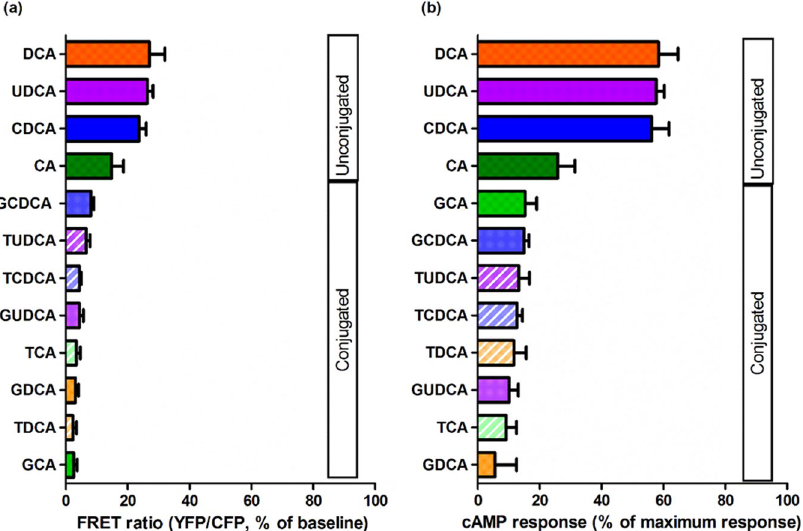
Figure 2. Bile acids and their conjugates ranked by their potency in inducing cAMP responses in NRVMs following stimulation at 100 µ